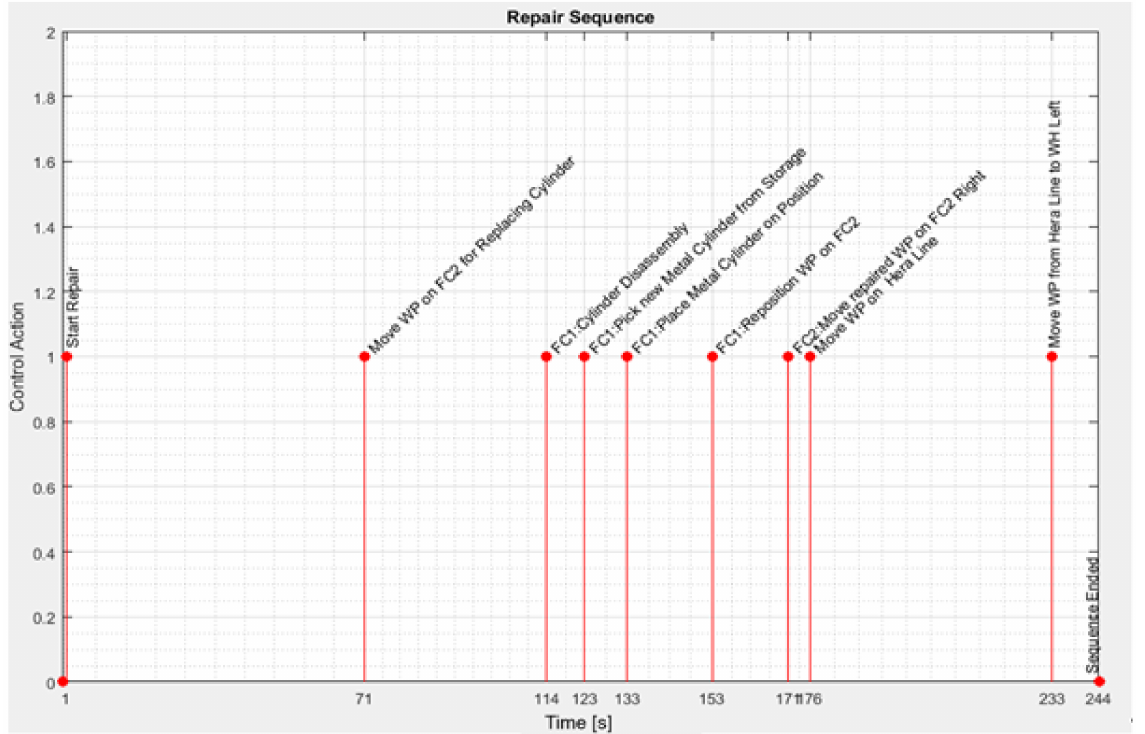
Figure 17. A/D/RML state transitions of repair